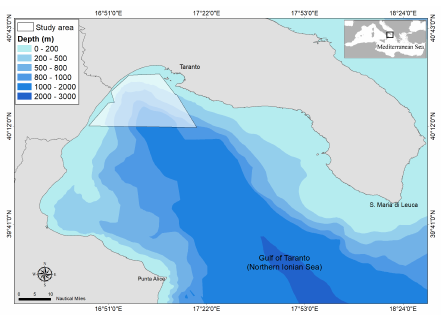
Figure 1. Map of the Gulf of Taranto (Northern Ionian Sea, Central-Eastern Mediterranean Sea) with indication of the survey area investigated from 2013 to